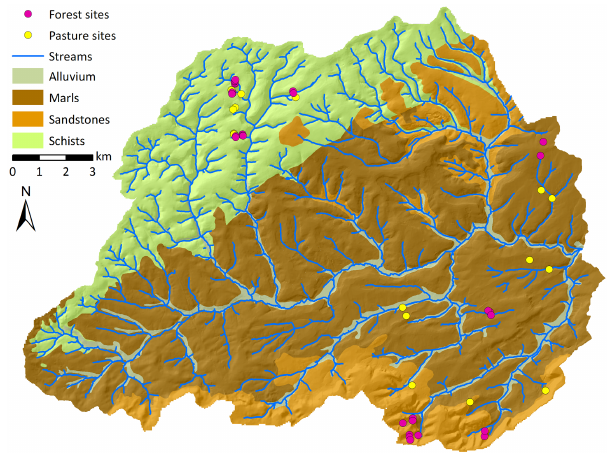
Figure 1. Map of the study site, the Attert catchment in Luxem-